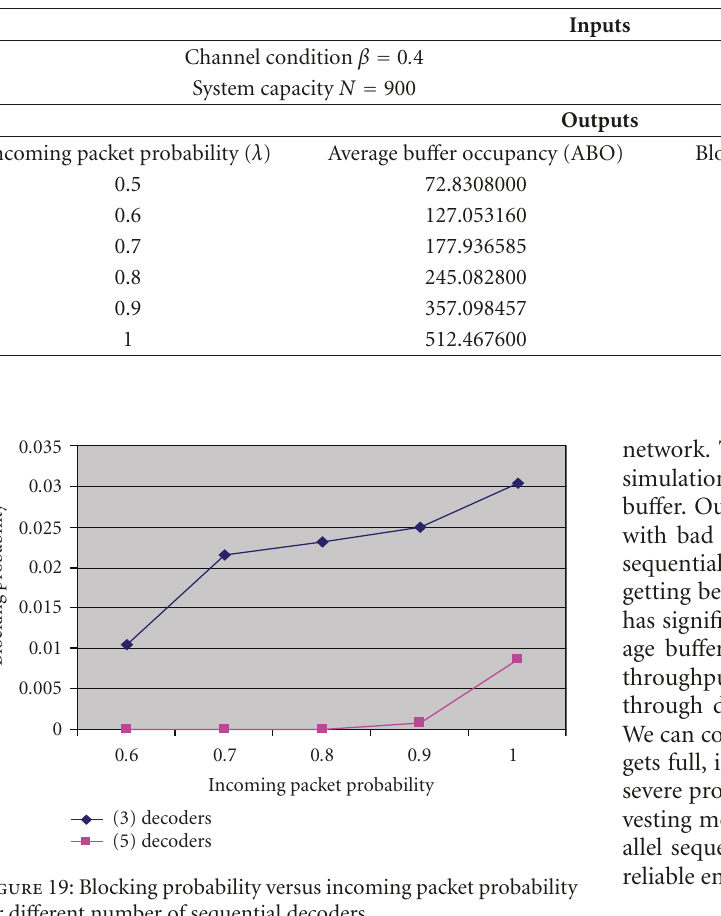
Table 3: ABO, blocking probability, and system throughput ( β = 0 . 4, T = 100).